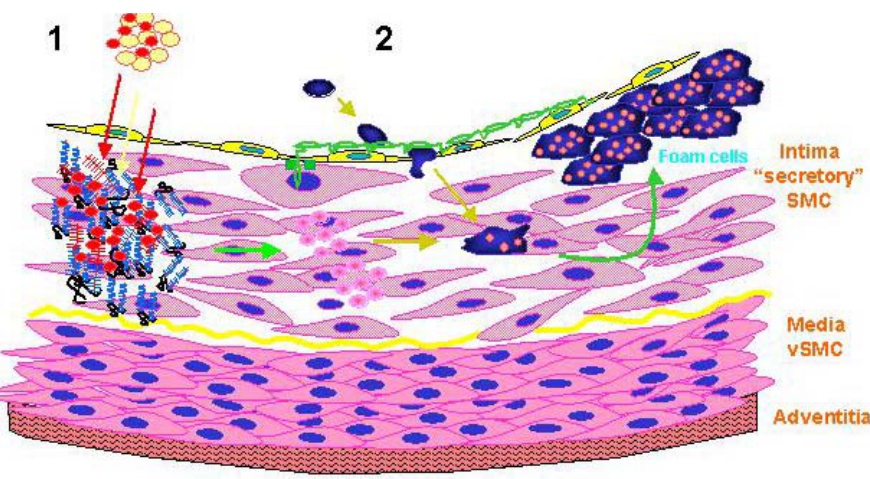
FIGURE 1 . Stylized presentation of the two processes of the initiation of atherosclerosis. (1) The binding and retention of atherogenic lipoproteins (LDL) to modified proteoglycans; (2) the binding and adhesion of monocytes/macrophages to the activated endothelium. See text for further